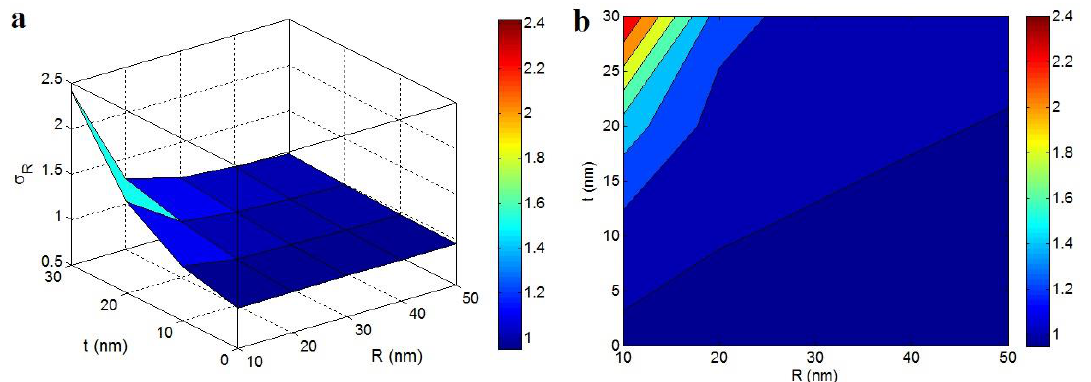
Figure 4. The influences of “ R ” and “ t ” terms on the relative strength assuming the percolating interphase based on the Pukanszky model at ( a ) 3D and ( b ) contour illustrations (σ m = 40 MPa, φ = 0.02, σ i = 100 MPa and l = 5 μm).